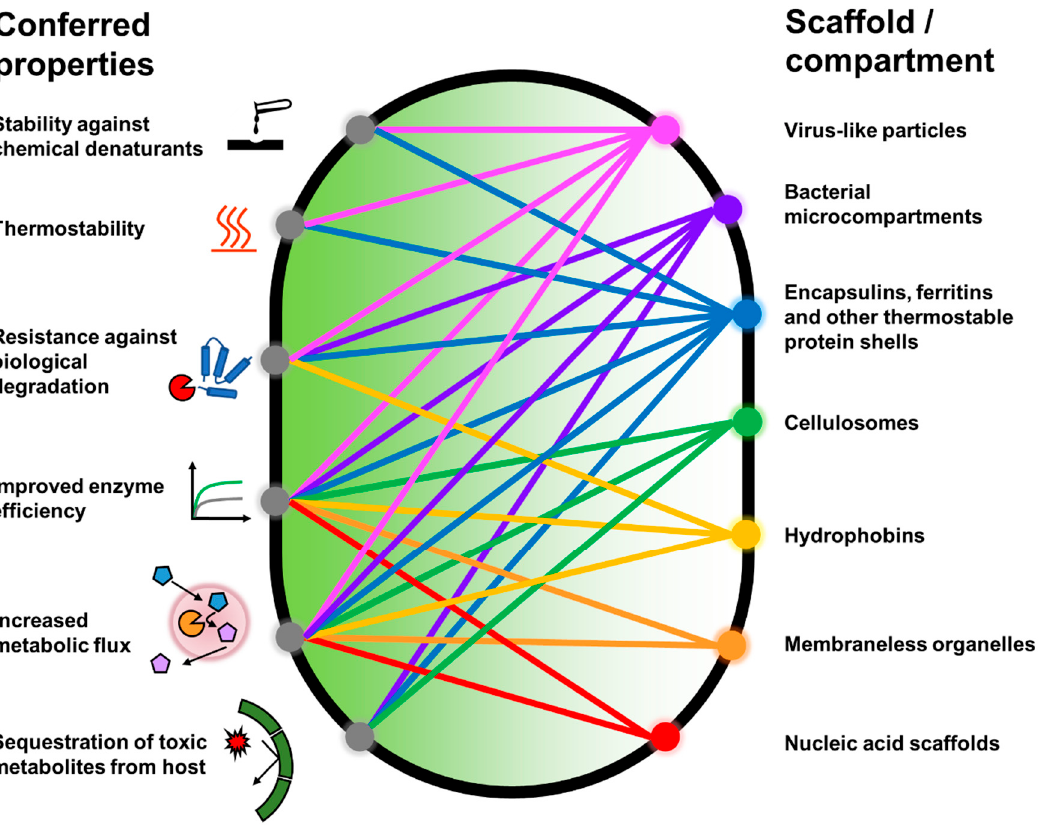
Figure 14. Summary of various properties in enzymes that have been conferred by the scaffolds discussed in this review.